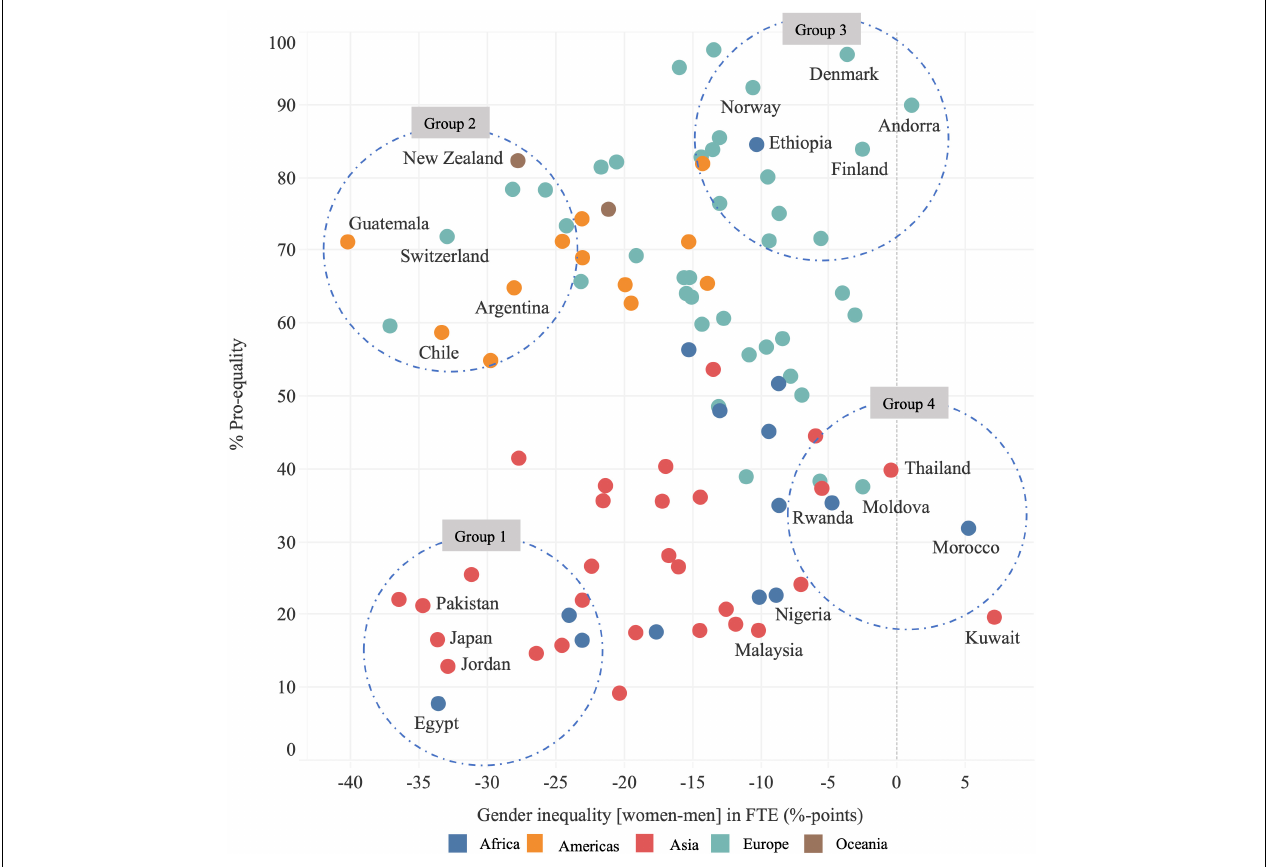
FIGURE 2 | Average pro-equality norms (PEN) and full-time employment (FTE). Each dot represents a country and colors indicate UN Regions. Negative values indicate that FTE is lower among women compared to men. Dotted circles show four country grouping based on levels of PEN and